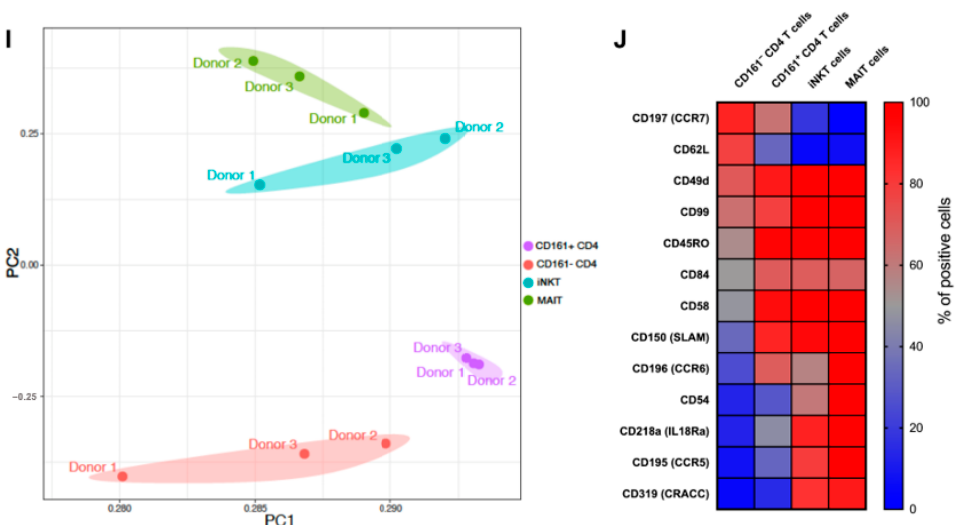
Figure 1. Phenotype and function of peripheral blood CD161 + CD4 + T cells in HIV-uninfected subjects. Levels of CD45RO ( A , n = 13), CCR5 ( B , n = 10), CCR6 ( C , n = 10), CCR9 ( D , n = 10), and IL-12RB1 ( E , n = 10) on CD161 − and CD161 + CD4 + T cells. Production of IFN γ ( F ), TNF ( G ), and IL-17 ( H ) by CD161 − and CD161 + CD4 + T cells following stimulation with IL-12 and IL-18 for 24 h ( n = 10). Principal component analysis (PCA) of the surface proteome dataset, with the four T cell populations plotted against principal component (PC) 1 and PC2 ( I ). Heat map showing the average expression levels of selected markers for the four T cell populations ( J ). ** p < 0.01, and *** p < 0.001.